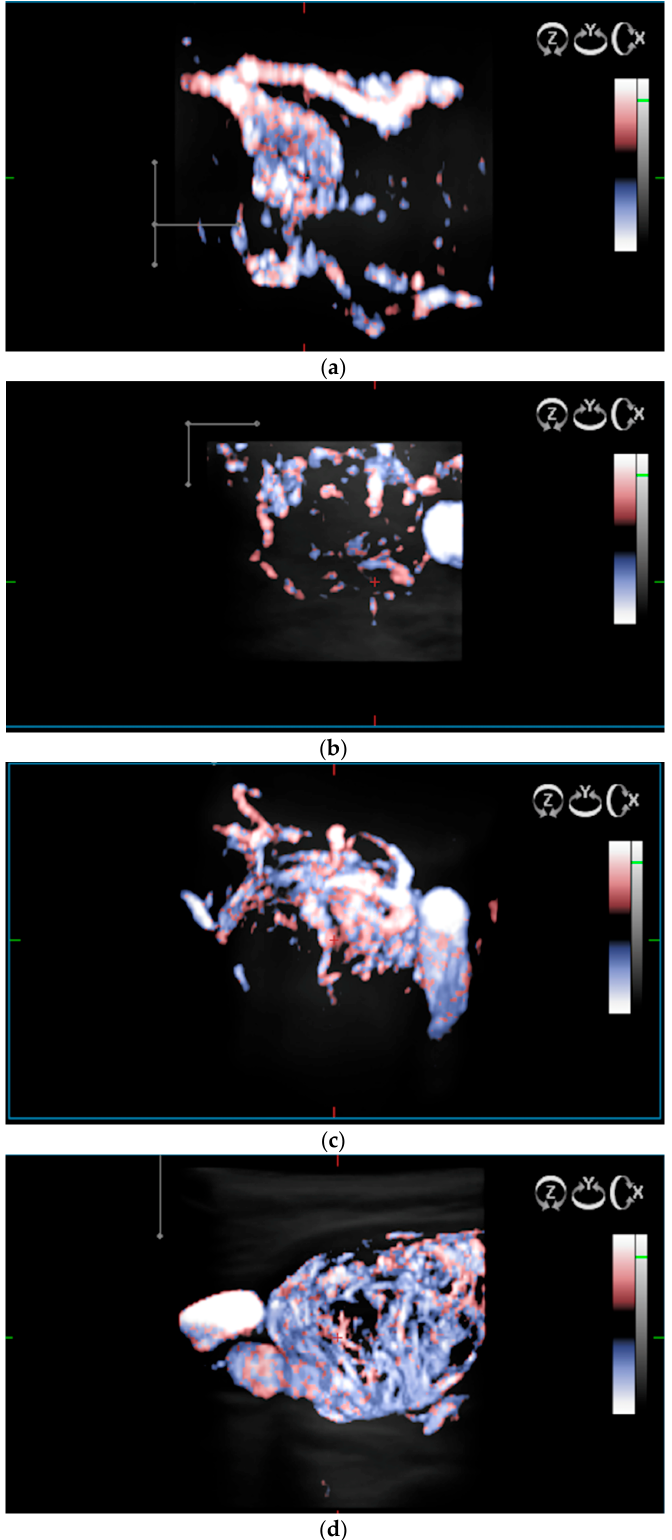
Figure 2. The observed 3D perinodular vascularization pattern: ( a ) No perinodular vascularization; ( b ) Low perinodular vascularization; ( c ) Moderate perinodular vascularization; ( d ) Intense perinodular